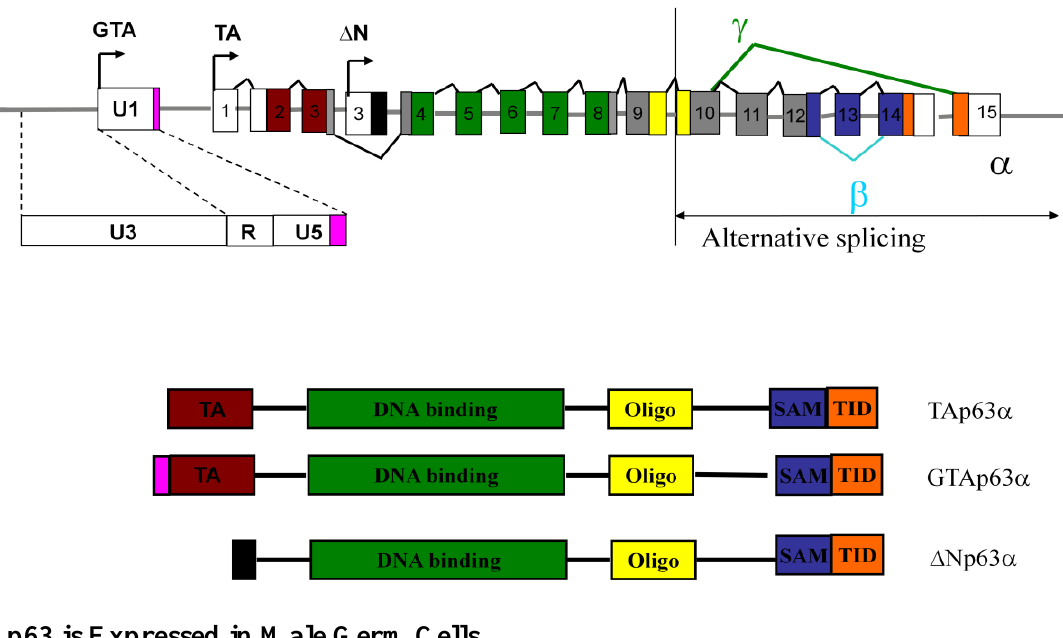
Figure 1. Genomic organization of human p63 locus. The p63 locus contains more than one promoter. Arrows designate the transcription initiation sites for the TAp63 (TA) and  Np63 (  N) as well as GTAp63 (GTA) transcripts from its distinct ERV-9 promoter. Alternate splicing within the 3' region of the gene results in the formation of the  ,  and  isoforms of the TAp63 and  Np63. The main structural domains include the N-terminal transactivation domain (TA), specific to the TAp63  and GTApTAp63  isoforms, DNA binding (green), oligomerization (yellow), SAM, or sterile alpha motif, a protein-protein interaction domain (purple) and the TID transactivation inhibitory domain (orange)